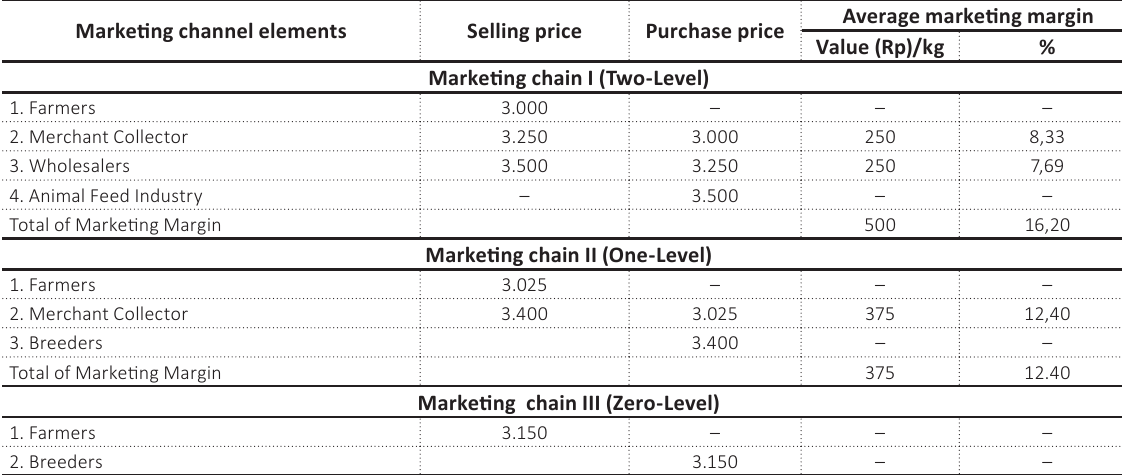
Table 5. Average marketing margin in a corn marketing channel